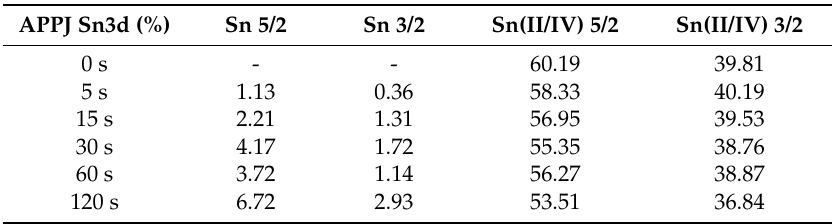
Table 2. Percentage of Sn species obtained from XPS